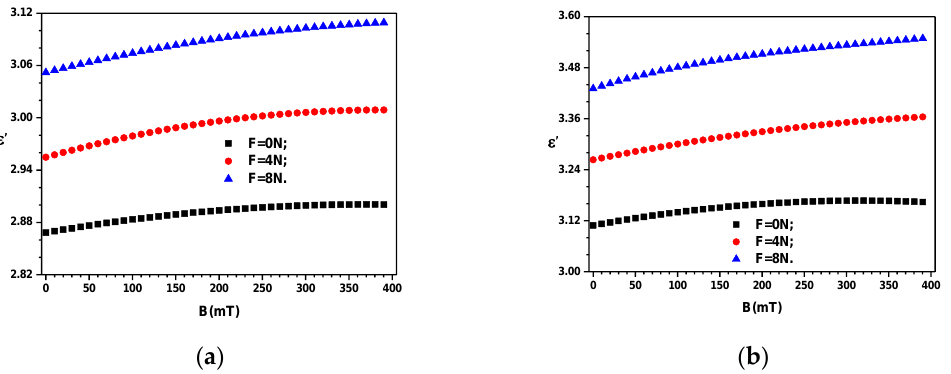
Figure 9. Relative dielectric permittivity 𝜀 ′ of the devices ED as a function of values B of the magnetic flux density superimposed on the electric field with the frequency f = 1 kHz, and values F of the force as a parameter. ( a ) MC 1 . ( b ) MC 2 .